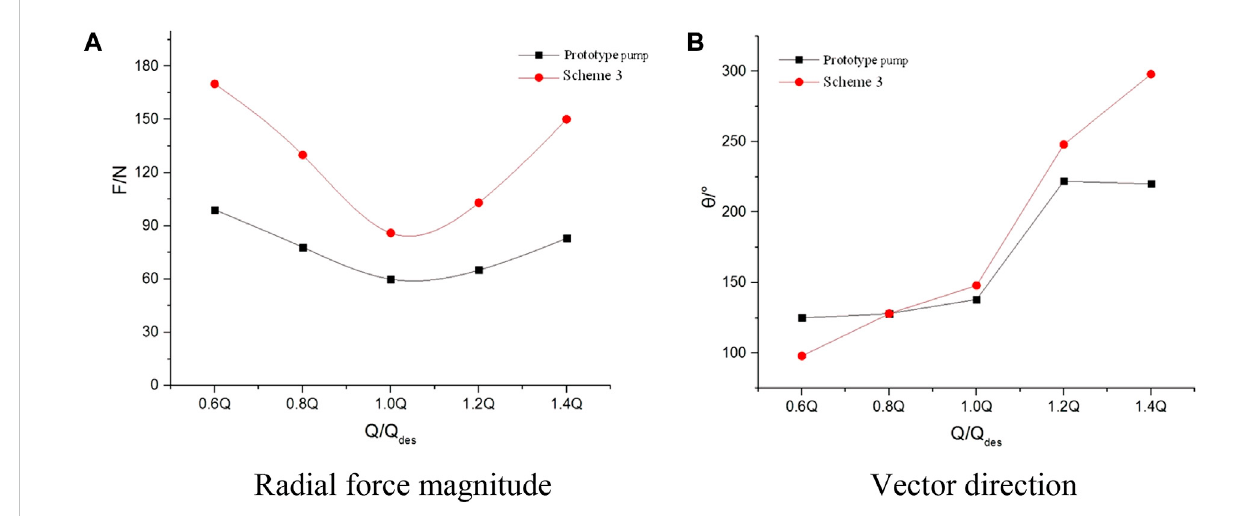
FIGURE 18 The magnitude and direction of radial force under different conditions. (A) Radial force magnitude; (B) Vector